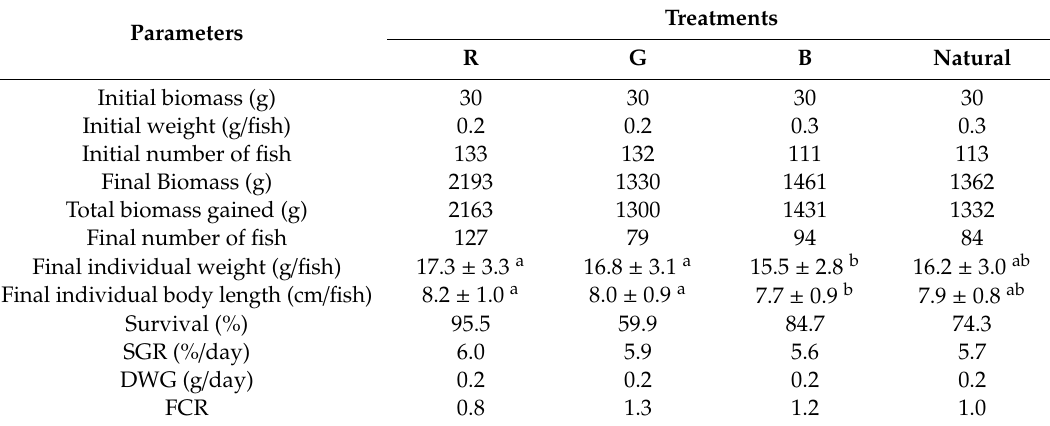
Table 4. Growth rates of Nile